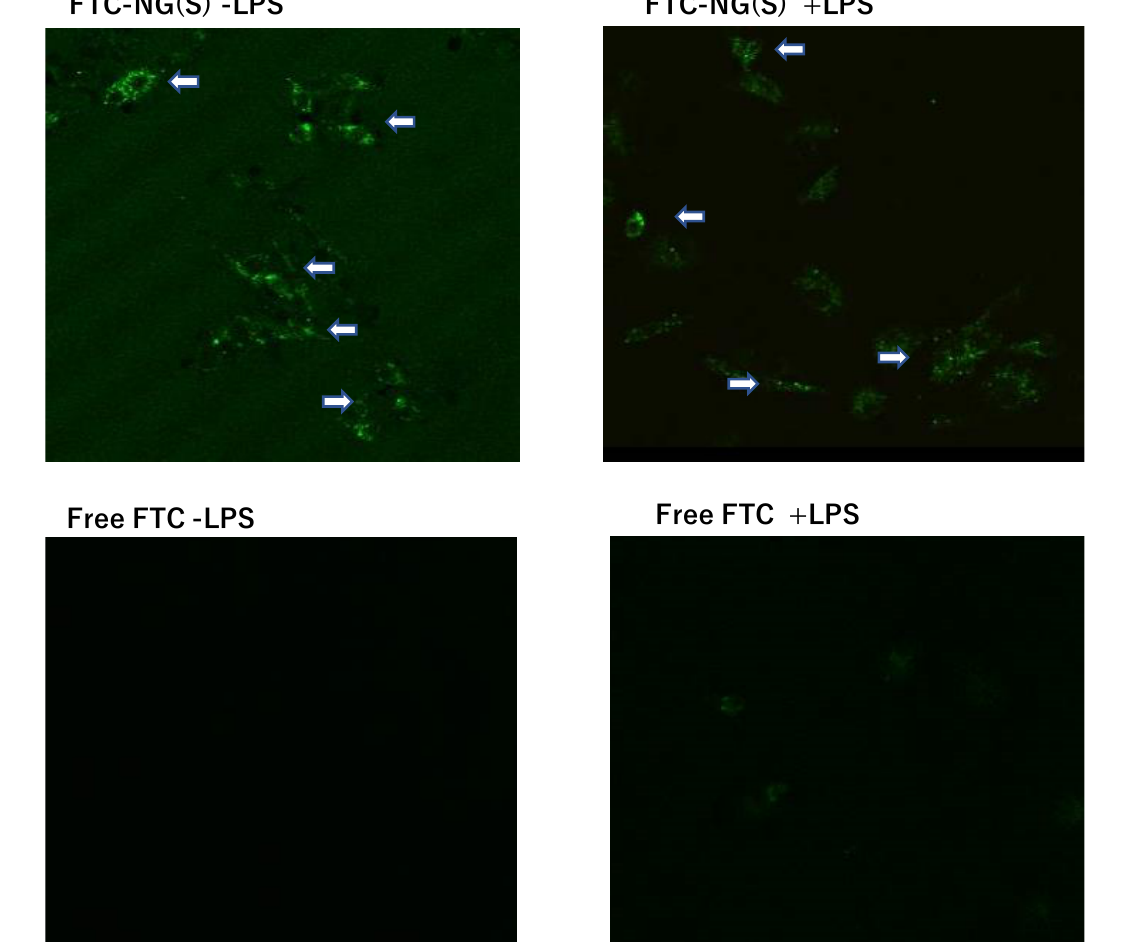
Figure 7. CLSM images of Raw 264.7 cells after incubation with FTC-NG(S) and FTC. The substances were added at the concentration of 1 µ g FTC eq. / mL. All the photos are shown in the same scale. − LPS: no LPS, + LPS: LPS added at 1 µ g / mL. The white arrows show the uptake of FTC-NG(S) by the cells.